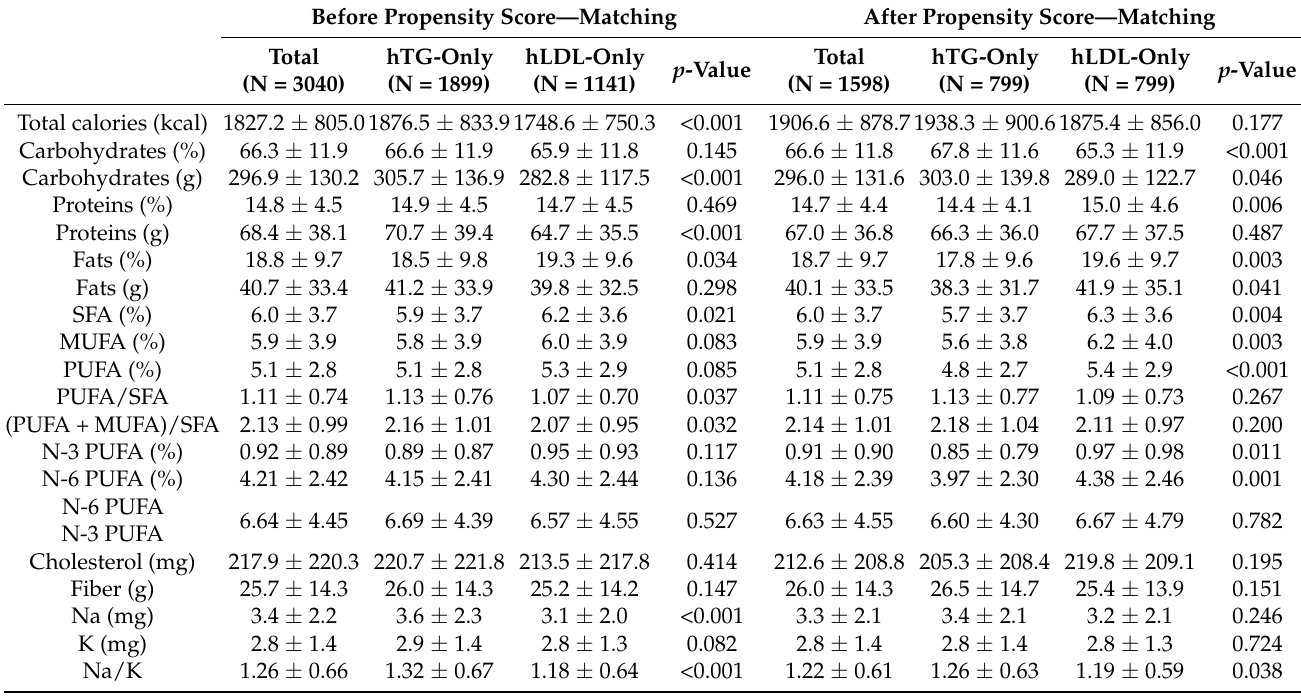
Table 5. Daily nutrient intake of study population according to the presence of hyper-low-density lipoprotein choles- terolemia alone or hypertriglyceridemia